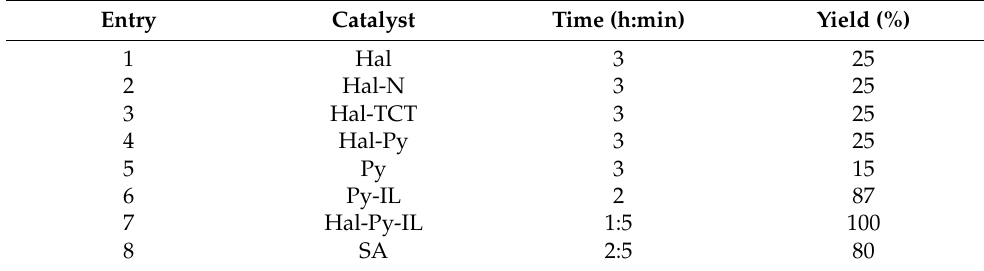
Table 2. Comparison of the activity of Hal-Py-IL with some control